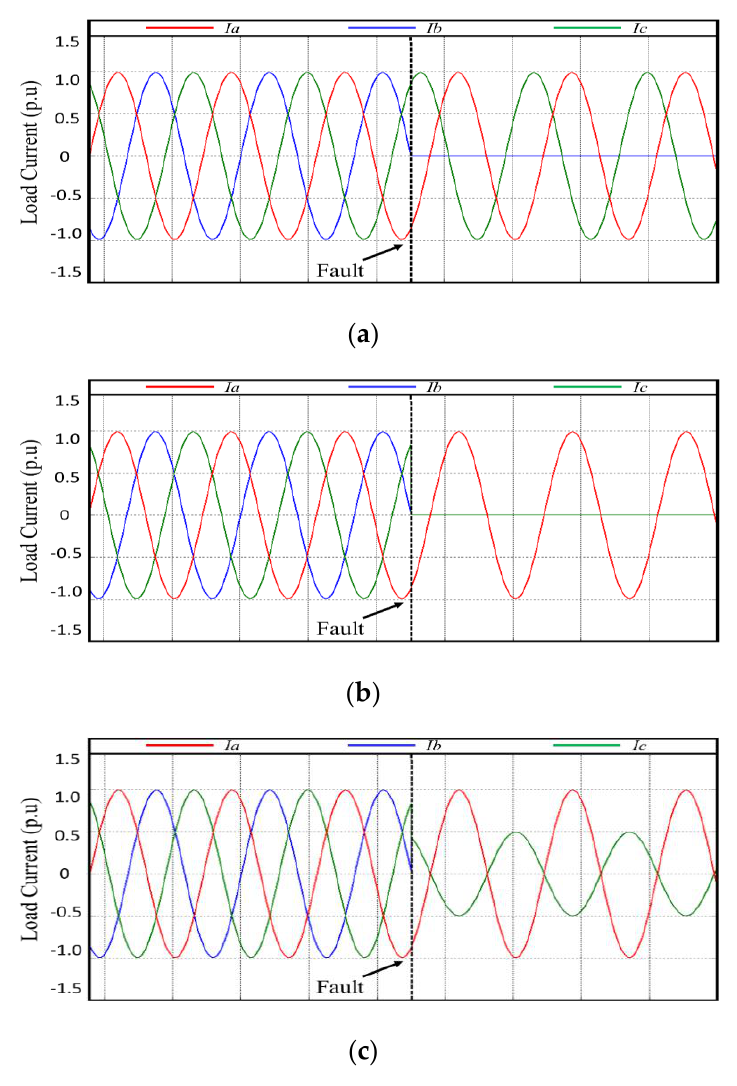
Figure 1. Load currents during: ( a ) single-line-to-ground (S-L-G), ( b ) double-line-to-ground (D-L-G), ( c ) single-line-to-line (S-L-L) faults (X-axis: 0.01 s/div; Y-axis: 0.5 p.u/div).